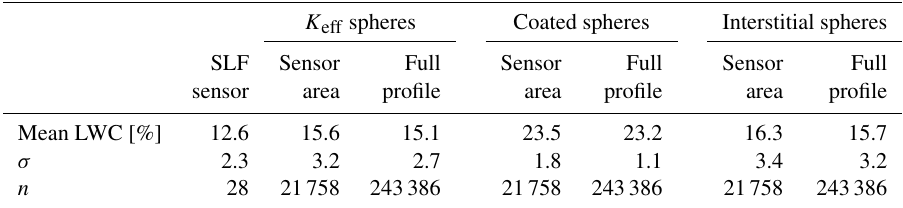
Figure 11. Results from the snowpit at Bridger Bowl Ski Area. (a) Density profile using 1000cm 3 wedge cutter and depth-averaged effective grain radius. (b) Map of effective grain radius across snowpit wall. (c) Map of liquid water content across snowpit wall with the SLF sensor vertical profile area outlined by the dashed red line. (d) Liquid water content profiles from the SLF Snow Sensor, NIR-HSI depth averaged across the entire width of the snowpit, and NIR-HSI depth averaged over the area covered by the SLF sensor area only. NaN (not a number) values in (b) and (c) correspond to no retrieval data due to a ruler that was placed in the scene. Table 3. Liquid water content retrieval results from the